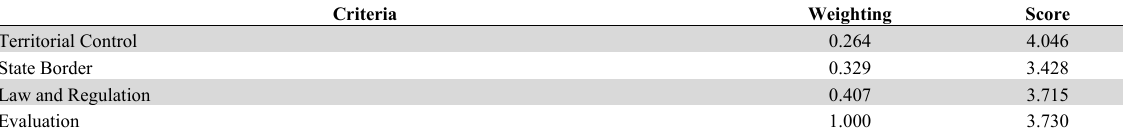
The weighting of Social Vulnerability Variables of Social Vulnerability